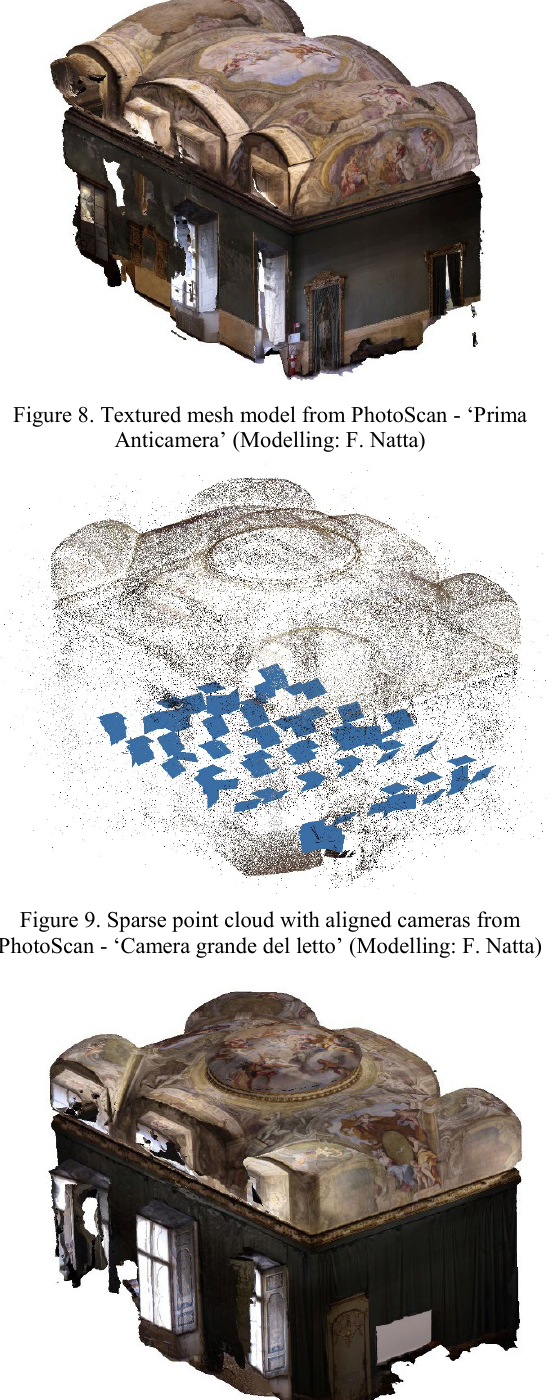
Figure 10. Textured mesh model from PhotoScan -